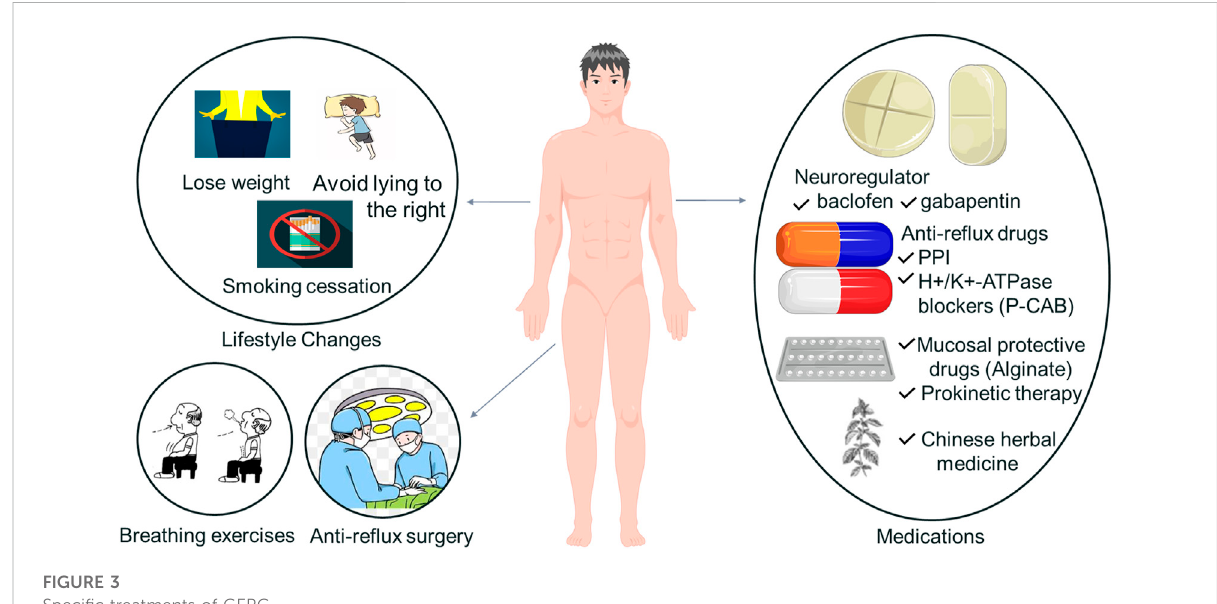
FIGURE 3 Speci fi c treatments of